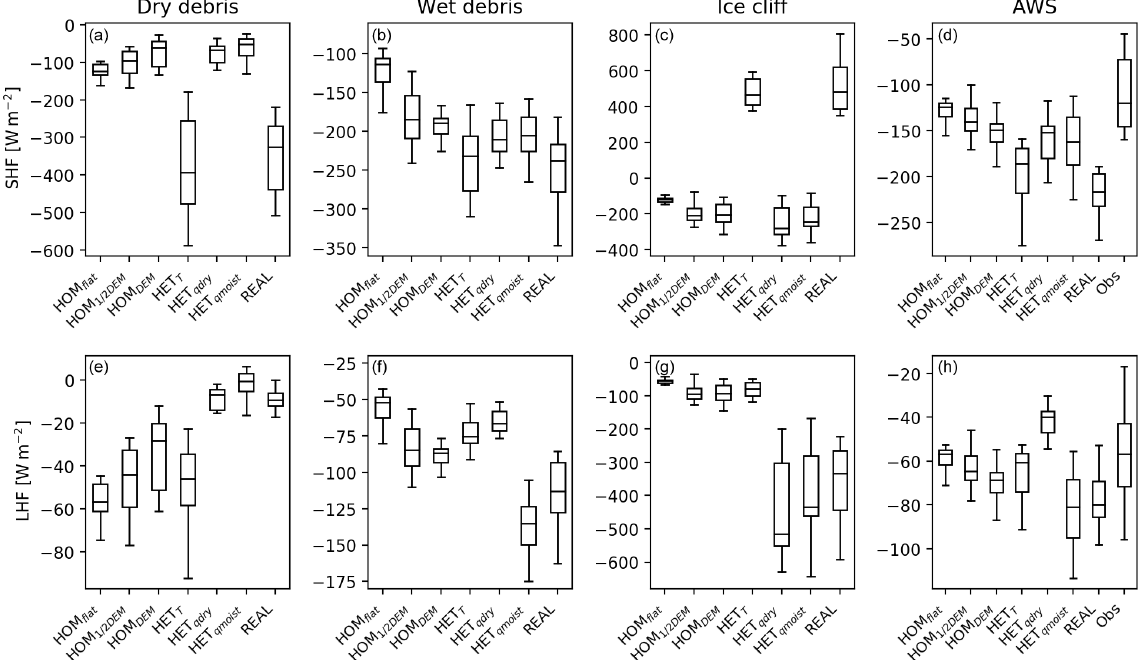
Figure 8. Box plots to show variability in possible outcomes at four different locations: dry debris (a, e) , wet debris (b, f) , ice cliff ( c, g ; all three points are taken as the average of nine grid points) and AWS location (weighted average over the footprint; d, h ) for all experiments (Table 1). Observations (Obs) of the SHF and LHF are shown in (d) and (h) . For all simulations the last hour of simulation data is taken and is resampled to a 5min average. Measurements are averaged over 5min. The time period taken from the AWS is